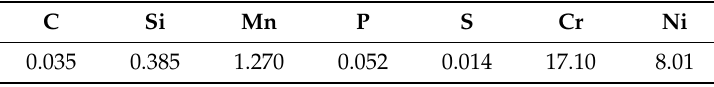
Table 1. Chemical composition of TP304 stainless steel